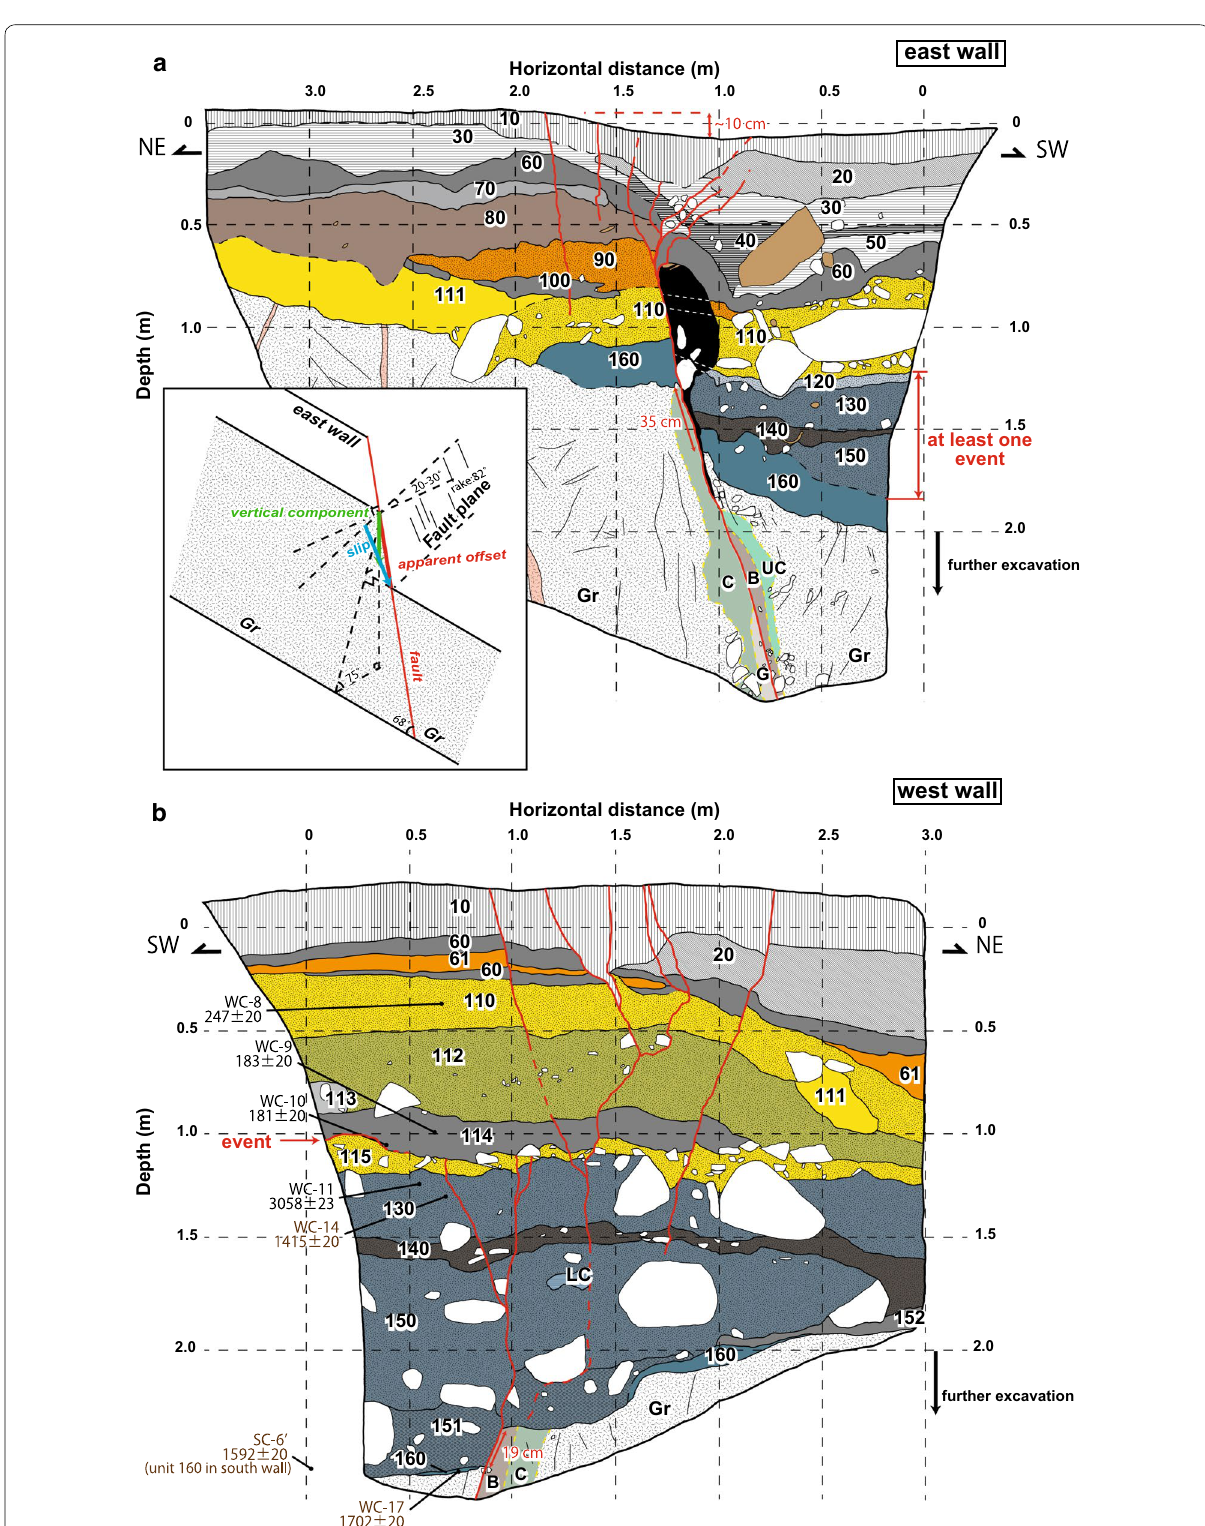
Fig. 7 Sketch log of a the east wall and b the west wall of the Mochiyama trench including radiocarbon ages (yr BP). Black lines are boundaries of sediment units and yellow-dashed lines are lithofacies boundaries within the